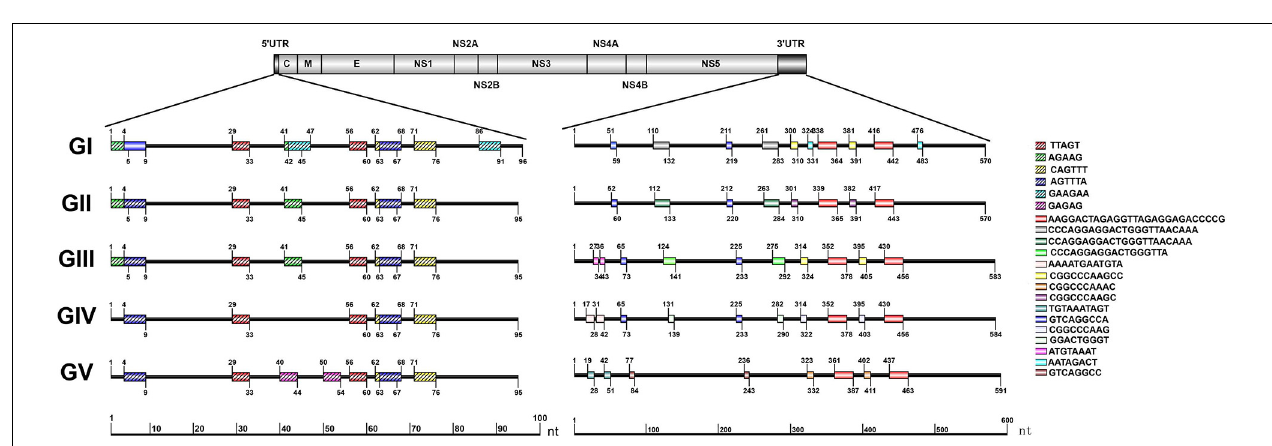
FIGURE 2 | The A, T, G, and C contents of the UTRs of different JEV genotypes. (A) The nucleotide contents of the 5 (cid:48) UTRs. (B) The nucleotide contents of the 3 (cid:48) UTRs. The abscissa indicates JEV genotypes and the ordinate represents the percentage of nucleotide contents. The red bar identifies adenine (A), green identifies cytosine (C), blue identifies guanine (G) and violet identifies thymine (T).